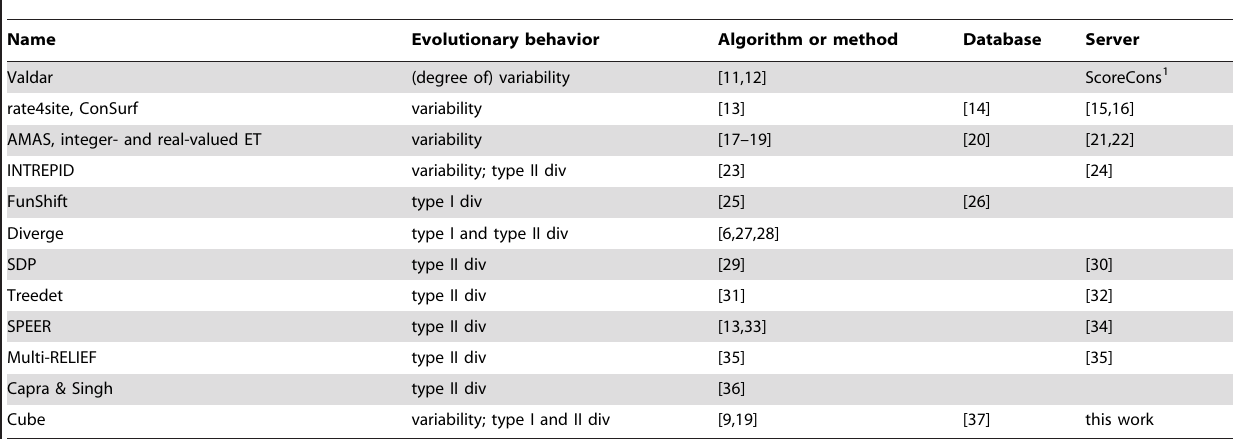
Table 1. Comparison of several applications for comparison of protein